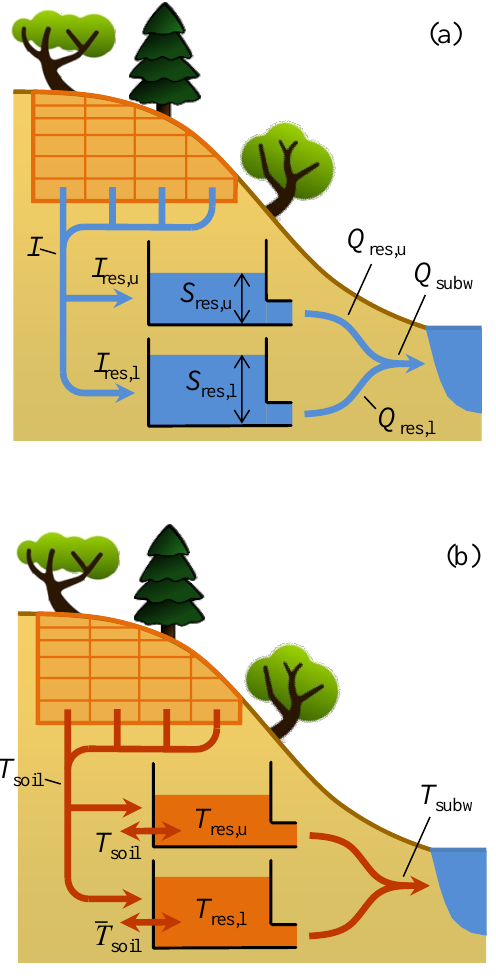
Figure A1. Illustrations of the models devised by Comola et al. (2015) for the computation of (a) subsurface flux discharge and (b) subsurface flux temperature. The symbols are defined in the